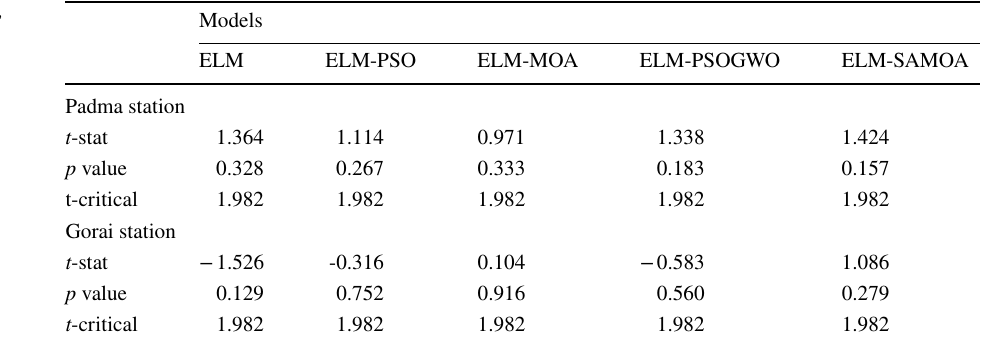
Table 5 t-test of single-phase, two-phase optimized and standalone ELM models for both stations using best input combination results